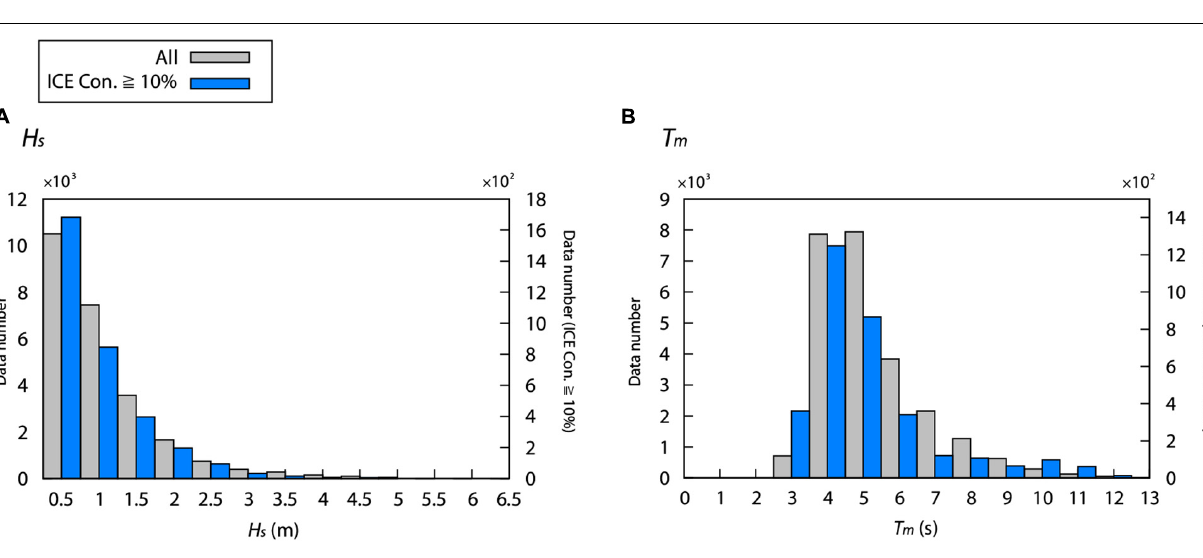
range was 0.035–1.1 Hz, which was logarithmically discretized into 30 increments. GEBCO, 2020 2 was used to provide the bottom topography and